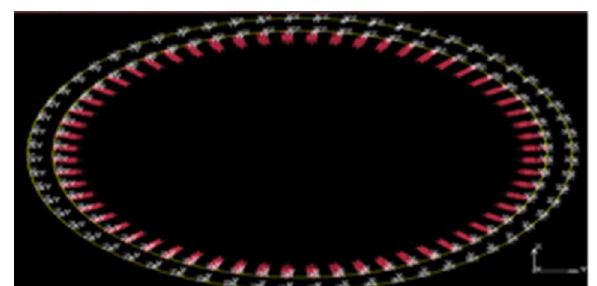
Figure 2 Welding path display 3. Applying boundary conditions 3.1 Selection of welding heat source The heat source model used in this paper is a double ellipsoidal sphere, and the simulation process assumes that the welding material and the parent material have the same performance characteristics. The double ellipsoid model is shown in Figure 3.